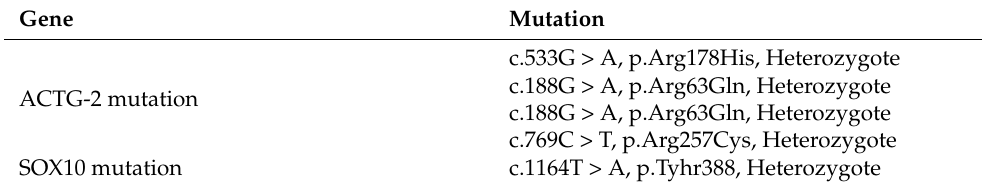
Table 3. Genetic